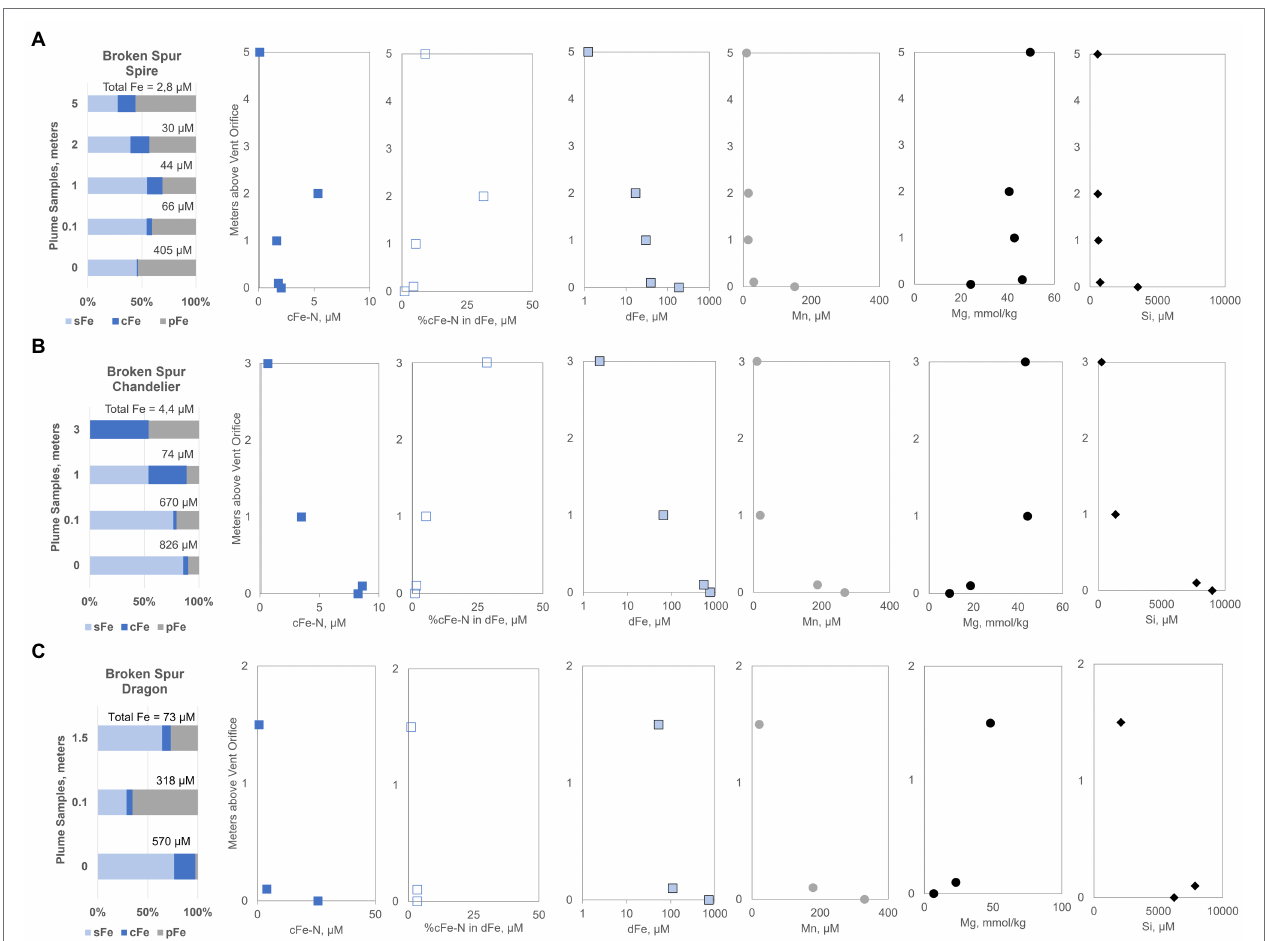
FIGURE 2 | Iron size fractionation data for Broken Spur vent fluids (A) Spire, (B) Chandelier, and (C) Dragon XIII are presented along with profiles containing distance from the orifice vs. measured different chemical species (e.g., cFe-N, dFe, Mn, Mg, and Si). sFe, soluble iron; cFe, colloidal iron; pFe, particulate iron; cFe-N, nanoparticle iron; dFe, dissolved